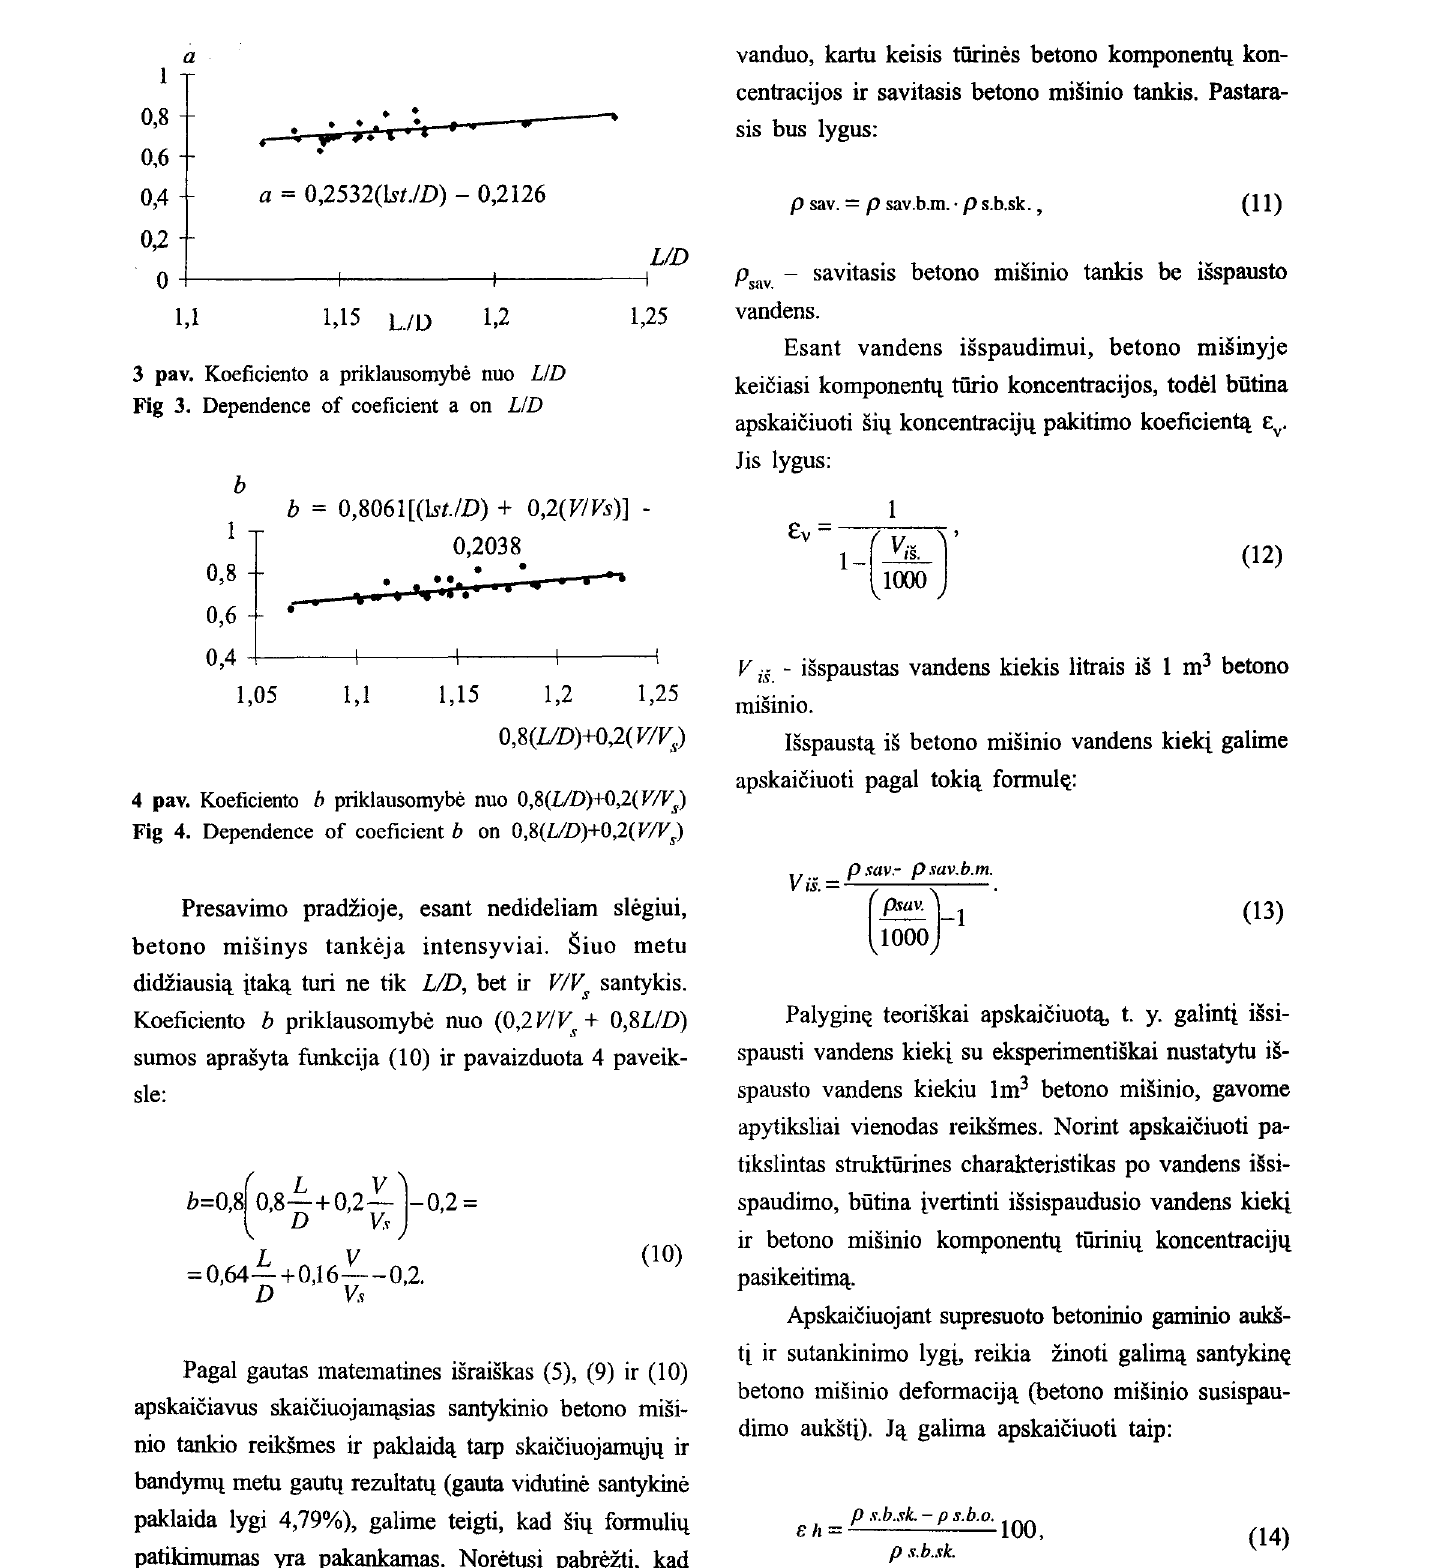
Fig 3. Dependence of coeficient a on LID